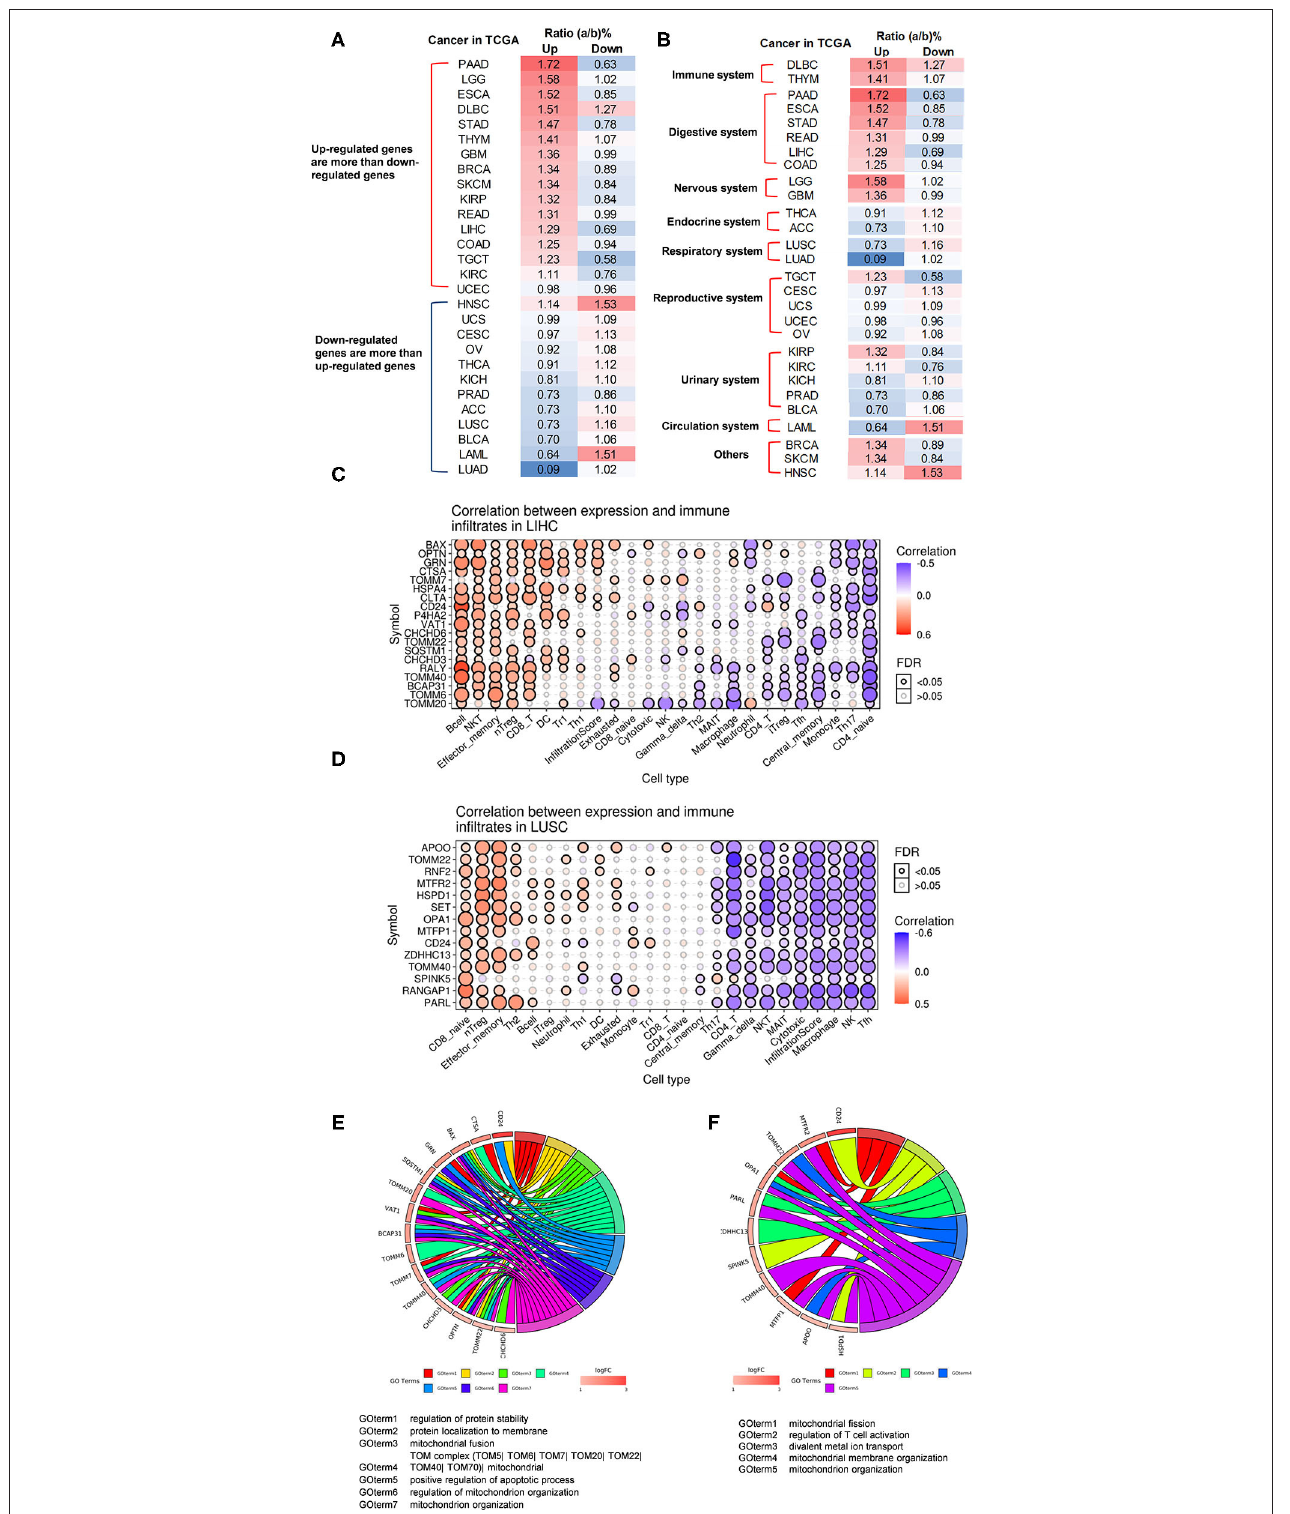
FIGURE 10 | The ratio of upregulated and downregulated OCRGs has different dominance in tumors of different systems, and differentially expressed OCRGs are correlated with immune infiltrates in liver hepatocellular carcinoma (LIHC) and lung squamous cell carcinoma (LUSC). (A) Tumors are listed according to the ratio